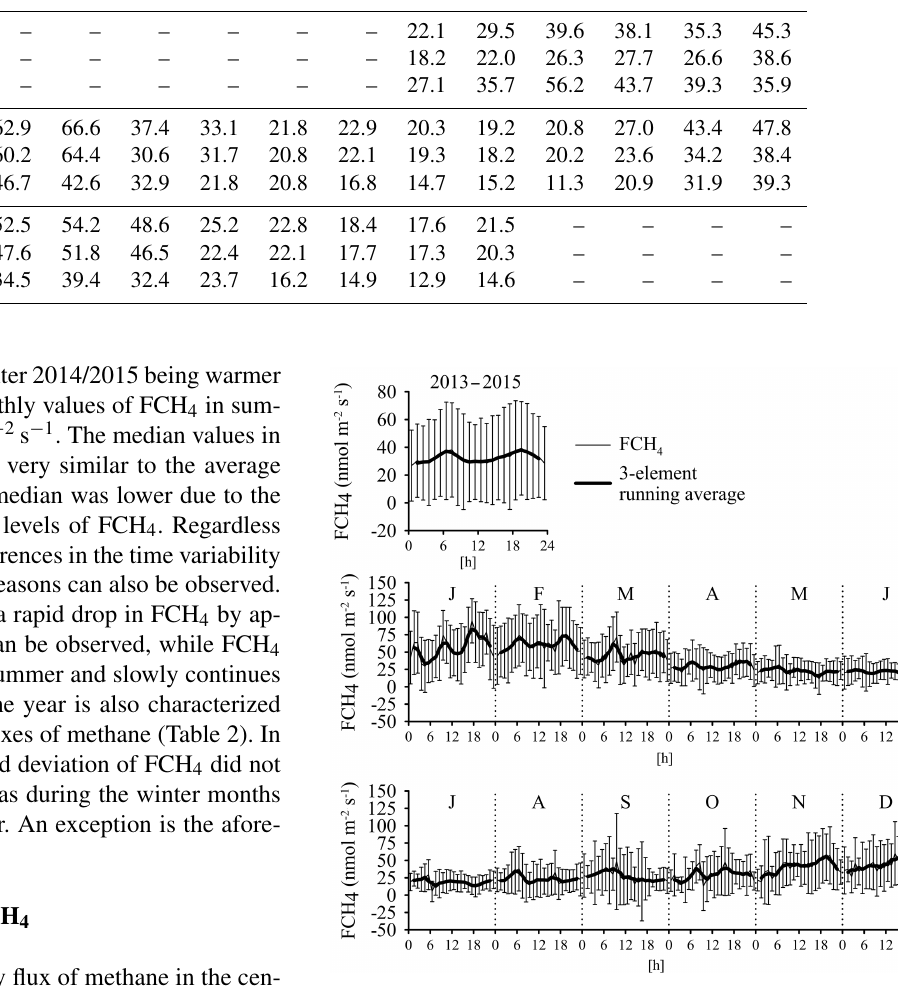
Figure 4. Mean diurnal variability of FCH 4 flux in the period July 2013–August 2015 (top left figure) and for months. Thin and thick black lines indicate, respectively, variability of FCH 4 and three-element running average of FCH 4 . Thin vertical lines indicate standard deviation of FCH 4